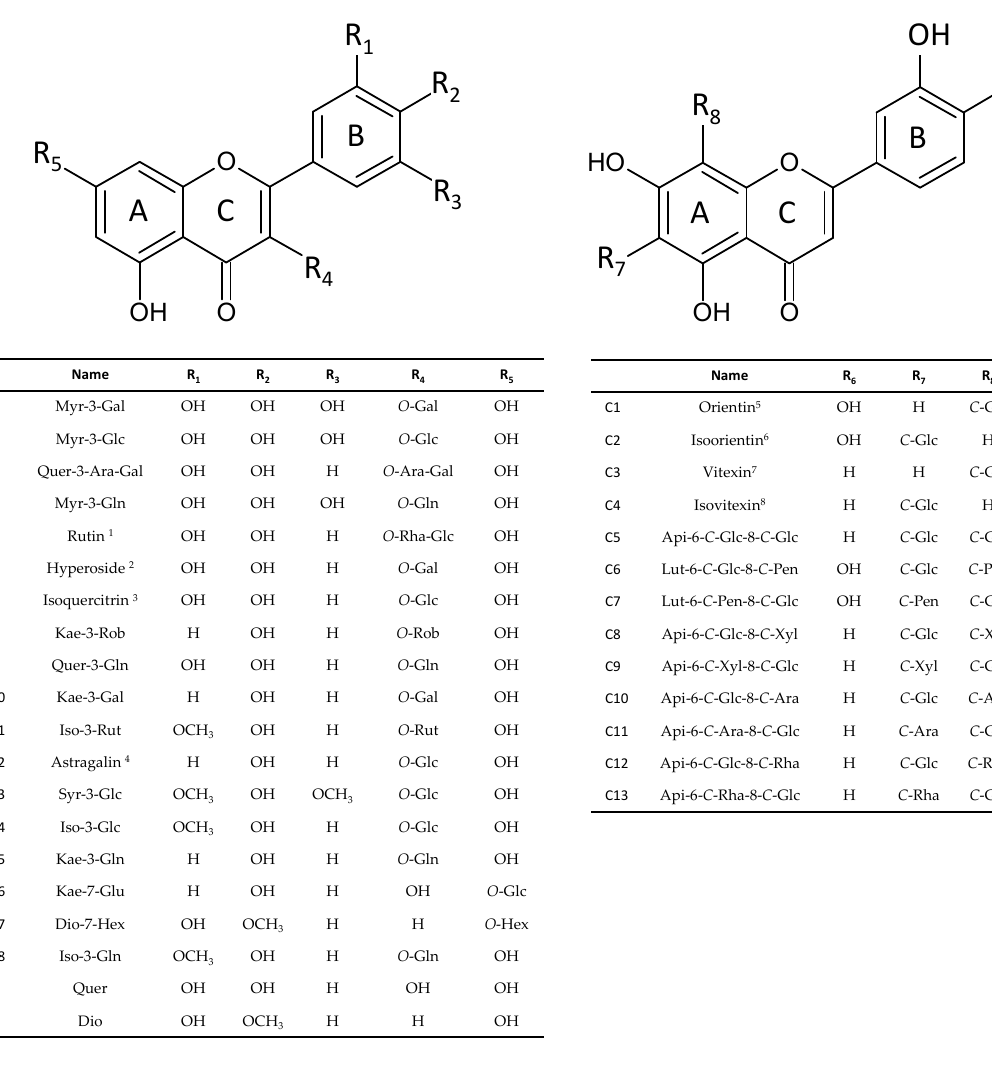
Figure 3. The chemical structures and names of the mains flavonoid O - (starting by O), C -glycosides (starting by C) and quercetin (Quer) and Diosmetin (Dio) aglycones from Nelumbo nucifera tissues. Flavonoid abbreviations used: Myr, myrycetin; Quer, quercetin; Kae, kaempferol; Iso, isorhamnetin; Syr, syringetin; Dio, diosmetin; Api, apigenin; Lut, luteolin. Sugar abbreviations used: Glc, glucoside; Gal, galactoside; Ara, arabionoside; Gln, glucuronide; Rut, rutinoside; Hex, hexoside; Xyl, xylose; Rha, rhamnose; Pen, pentose. 1 rutin, quercetin 3- O -rhamnopyranosyl-(1 → 6)-glucopyranoside; 2 hyperoside, quercetin 3- O -galactoside; 3 isoquercitrin, quercetin 3- O -glucoside; 4 Astragalin, kaempferol 3- O -glucoside; 5 orientin, luteolin 8- C - β -D-glucopyranoside; 6 isoorientin, luteolin 6- C - β - D-glucopyranoside; 7 vitexin, apigenin 8- C - β -D-glucopyranoside; 8 isovitexin, apigenin 6- C - β -D- glucopyranoside. Adapted from Chen et al. [25] and Li et al. [35].